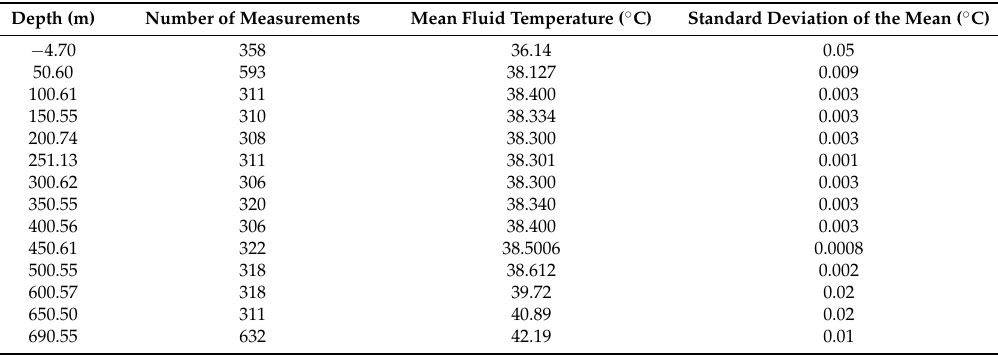
Table 1. Processed field data for a dual-zone water-injection